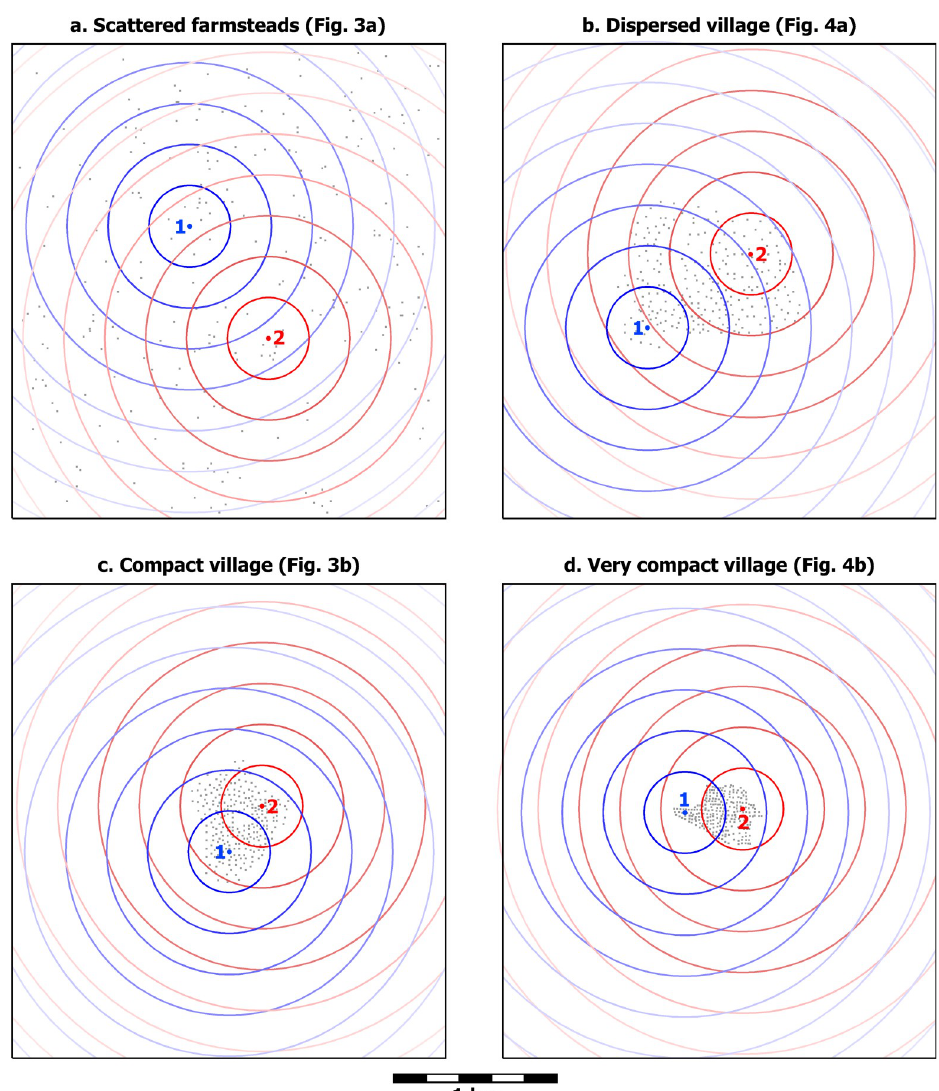
Fig 6. Interaction networks. Overlapping interaction networks of two households in each of the four household distributions in Figs 3 and 4. Fading colors reflect the diminishing average frequency of interaction at intervals of 250